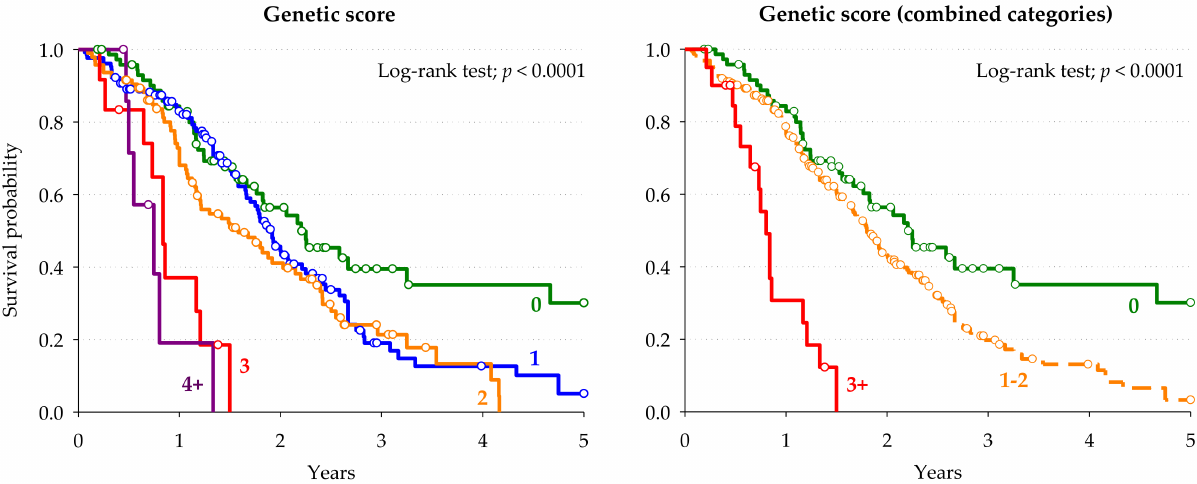
Figure 4. Kaplan-Meier estimates of overall survival according to the genetic score in the combined case series ( n =